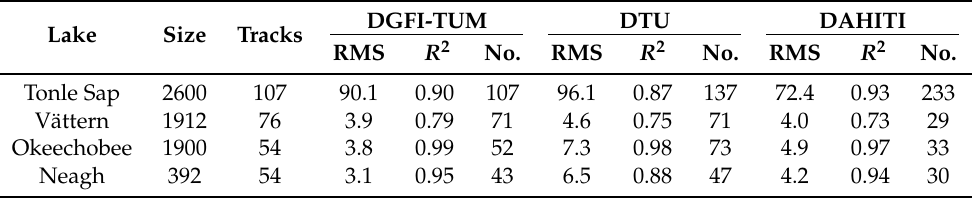
Table 2. Root mean square (RMS) differences (cm) and squared correlation coefficients ( R 2 ) of the water level time series derived from satellite altimetry with respect to in-situ gauging data for the time span (8 April 2010–31 December 2015). Furthermore the size of the lakes (km 2 ), the number of CryoSat-2 tracks crossing the lakes as well as the number of points in the water level time series (No.) are given (identical with the number of used data points for the comparison with in-situ